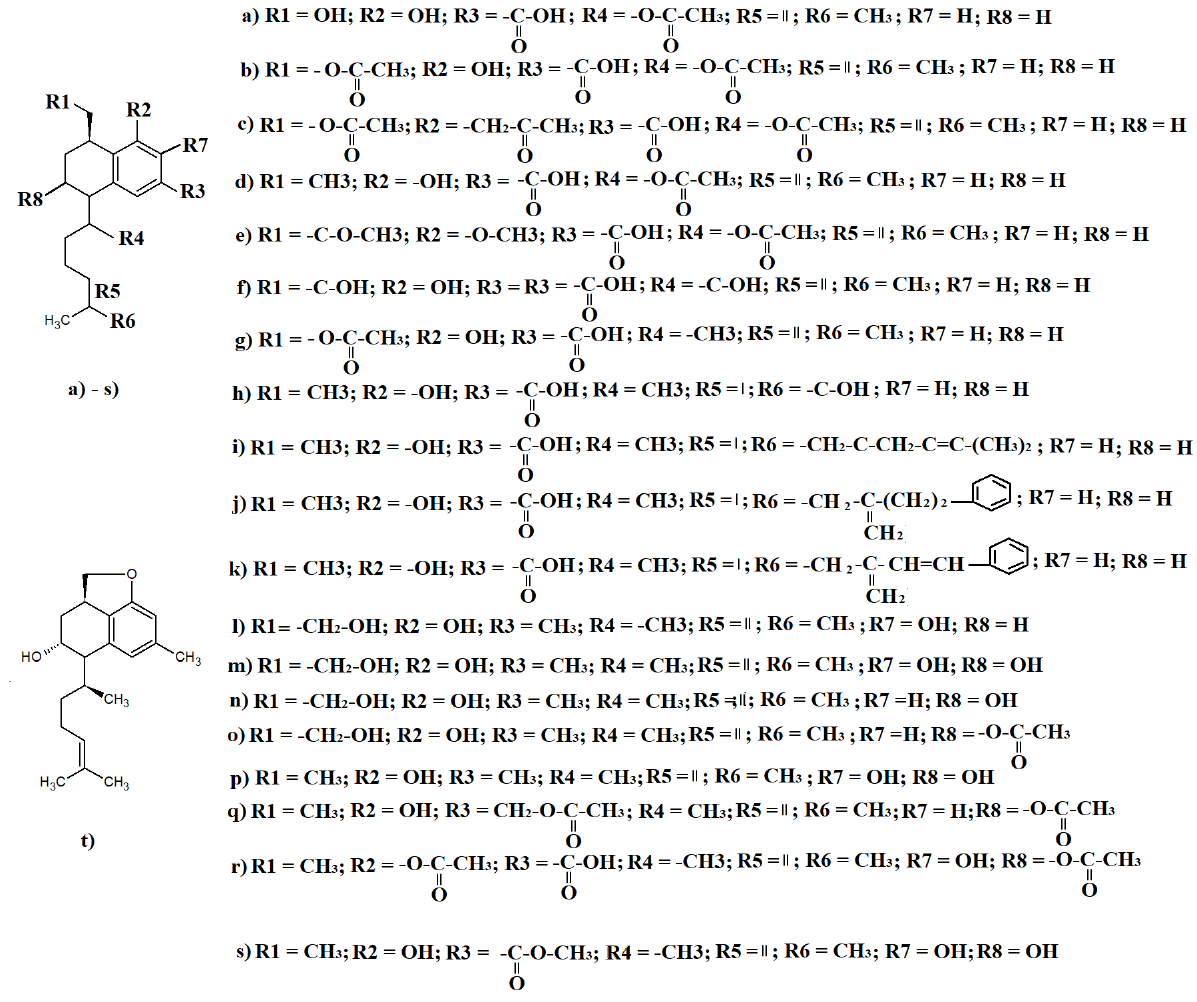
Figure 5. Selected serrulatane diterpenoids identified in Eremophila spp.: ( a ) 18-acetoxy-8,20-dihydroxyserrulat-14-en-19-oic acid; ( b ) 18,20-diacetoxy-8-hydroxyserrulat-14-en-19-oic acid; ( c ) 8,18,20-triacetoxyserrulat-14-en-19-oic acid; ( d ) 18-acetoxy-8-hydroxyserrulat-14-en-19-oic acid; ( e ) 8,20-diacetoxyserrulat-14-en-19-oic acid; ( f ) 8,18,20-trihydroxyserrulat-14- en-19-oic acid; ( g ) 20-acetoxy-8-hydroxyserrulat-14-en-19-oic acid; ( h ) 8,16-dihydroxyserrulat-19-oic acid; ( i ) 8-hydroxy-16-[4-methylpent-3-enoyloxy]serrulat-19-oic acid; ( j ) 8-hydroxy-16-hydrocinnamoyloxyserrulat-19-oic acid; ( k ) 8-hydroxy-16-cinnamoyloxyserrulat-19-oic acid; ( l ) 8-hydroxyserrulat-14- en-19-oic acid; ( m ) 8,20- trihydroxyserrulat-14-ene; ( n ) serrulat-14-en-3,7,8,20-tetraol; ( o ) 3-acetoxy-7,8-dihydroxyserrulat-14-en-19-oic acid; ( p ) 3,7,8-trihydroxyserrulat-14-en-19-oic acid; ( q ) 3,19-diacetoxy-8-hydroxyserrulat-14-ene; ( r ) 3,8-diacetoxy-7-hydroxyserrulat-14-en-19-oic acid; and ( s ) 3,7,8-trihydroxyserrulat-14-en-19-oic acid methyl ester. 18-Acetoxy-8-hydroxyserrulat-14-en-19-oic acid and four additional serrulatane diterpenoids have been isolated from E. glabra : 8,16-dihydroxyserrulat-19-oic acid (Figure 5h): 8-hydroxy-16-[4-methylpent-3-enoyloxy]serrulat-19-oic acid (Figure 5i), 8-hydroxy- 16-hydrocinnamoyloxyserrulat-19-oic acid (Figure 5j), 8-hydroxy-16-cinnamoyloxyserru- lat-19-oic acid (Figure 5k), and 8-hydroxyserrulat-14- en-19-oic acid (Figure 5l), with yields of 0.01–0.05% (m/m) being obtained the dried leaves [17]. Multiple serrulatane diterpenoids have also been identified in E. duttonii leaves, including 8, 20-trihydroxyser- rulat-14-ene (Figure 5m, and serrulat-14-en-3, 7, 8, 20-tetraol (Figure 5n), although the ex- traction yields were not specified in those studies [20,67–69]. One of those studies also reported that both of these compounds had noteworthy antibacterial activity towards Staphylococcus aureus [20].